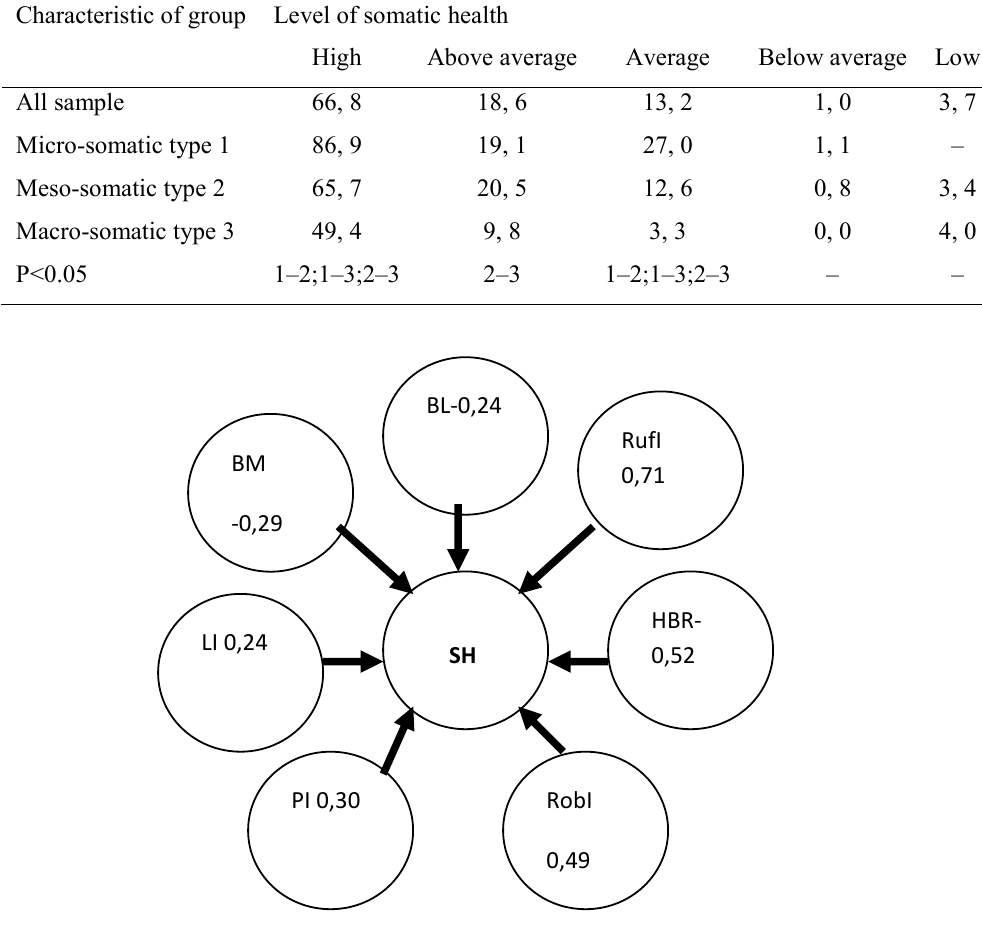
Fig.2 Factors, influencing on students’ somatic health (figures are correlation coefficients with р <0.